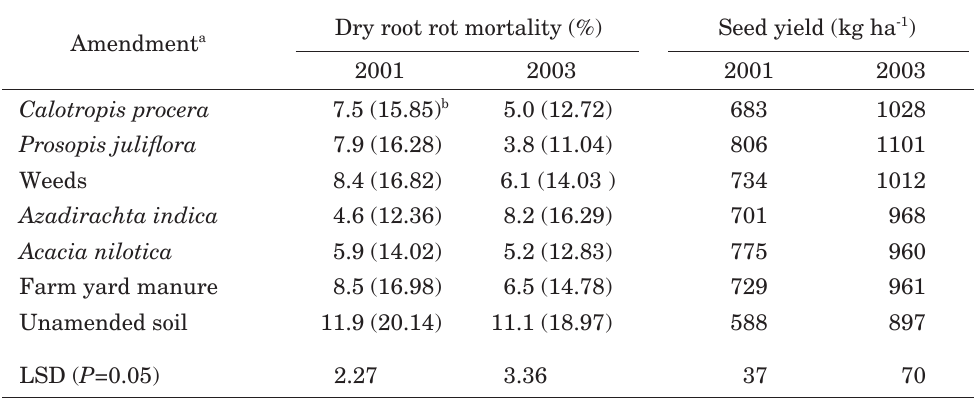
Table 5. Micronutrients (ppm) a in compost-amended and unamended soil and cowpea plants after harvest in 2003.